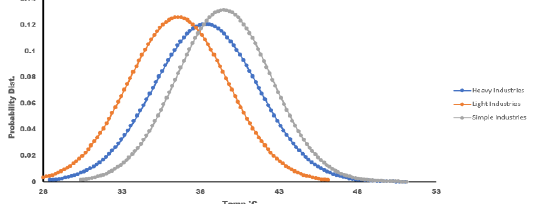
Figure 7. Showing all hotpots targets for (a) all Categories of industries (Heavy, Medium and Light (b) Heavy Industries (c) Medium Industries (d) Light Industries at Pasir Gudang